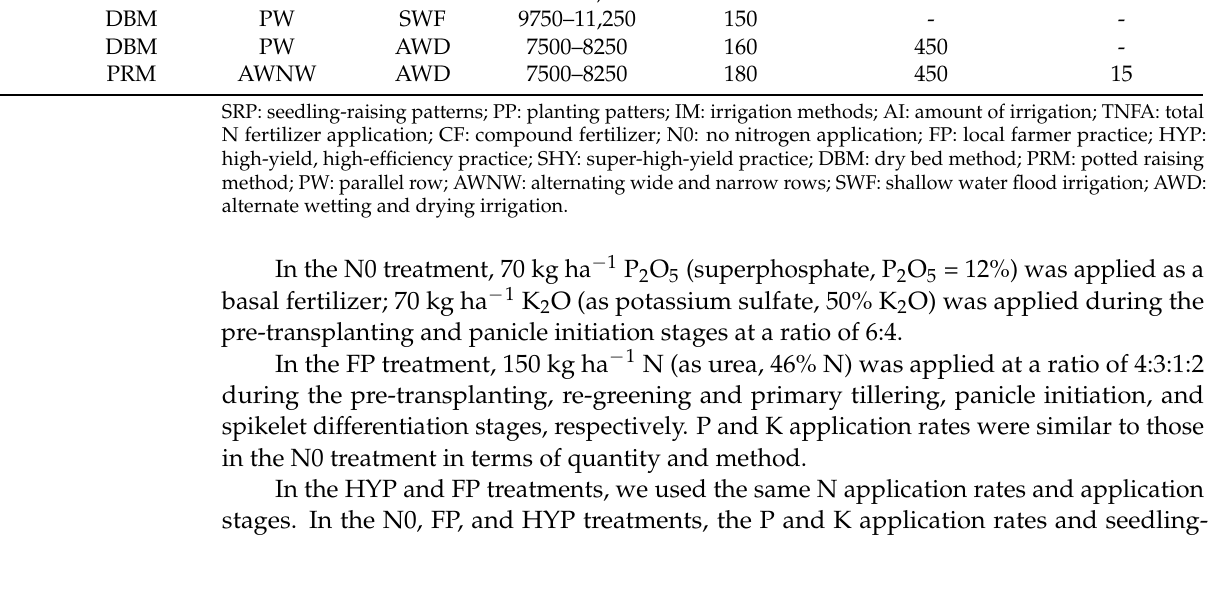
Table 1. Fertilization application regime and cultivation measures under different cultivation modes. Treatment